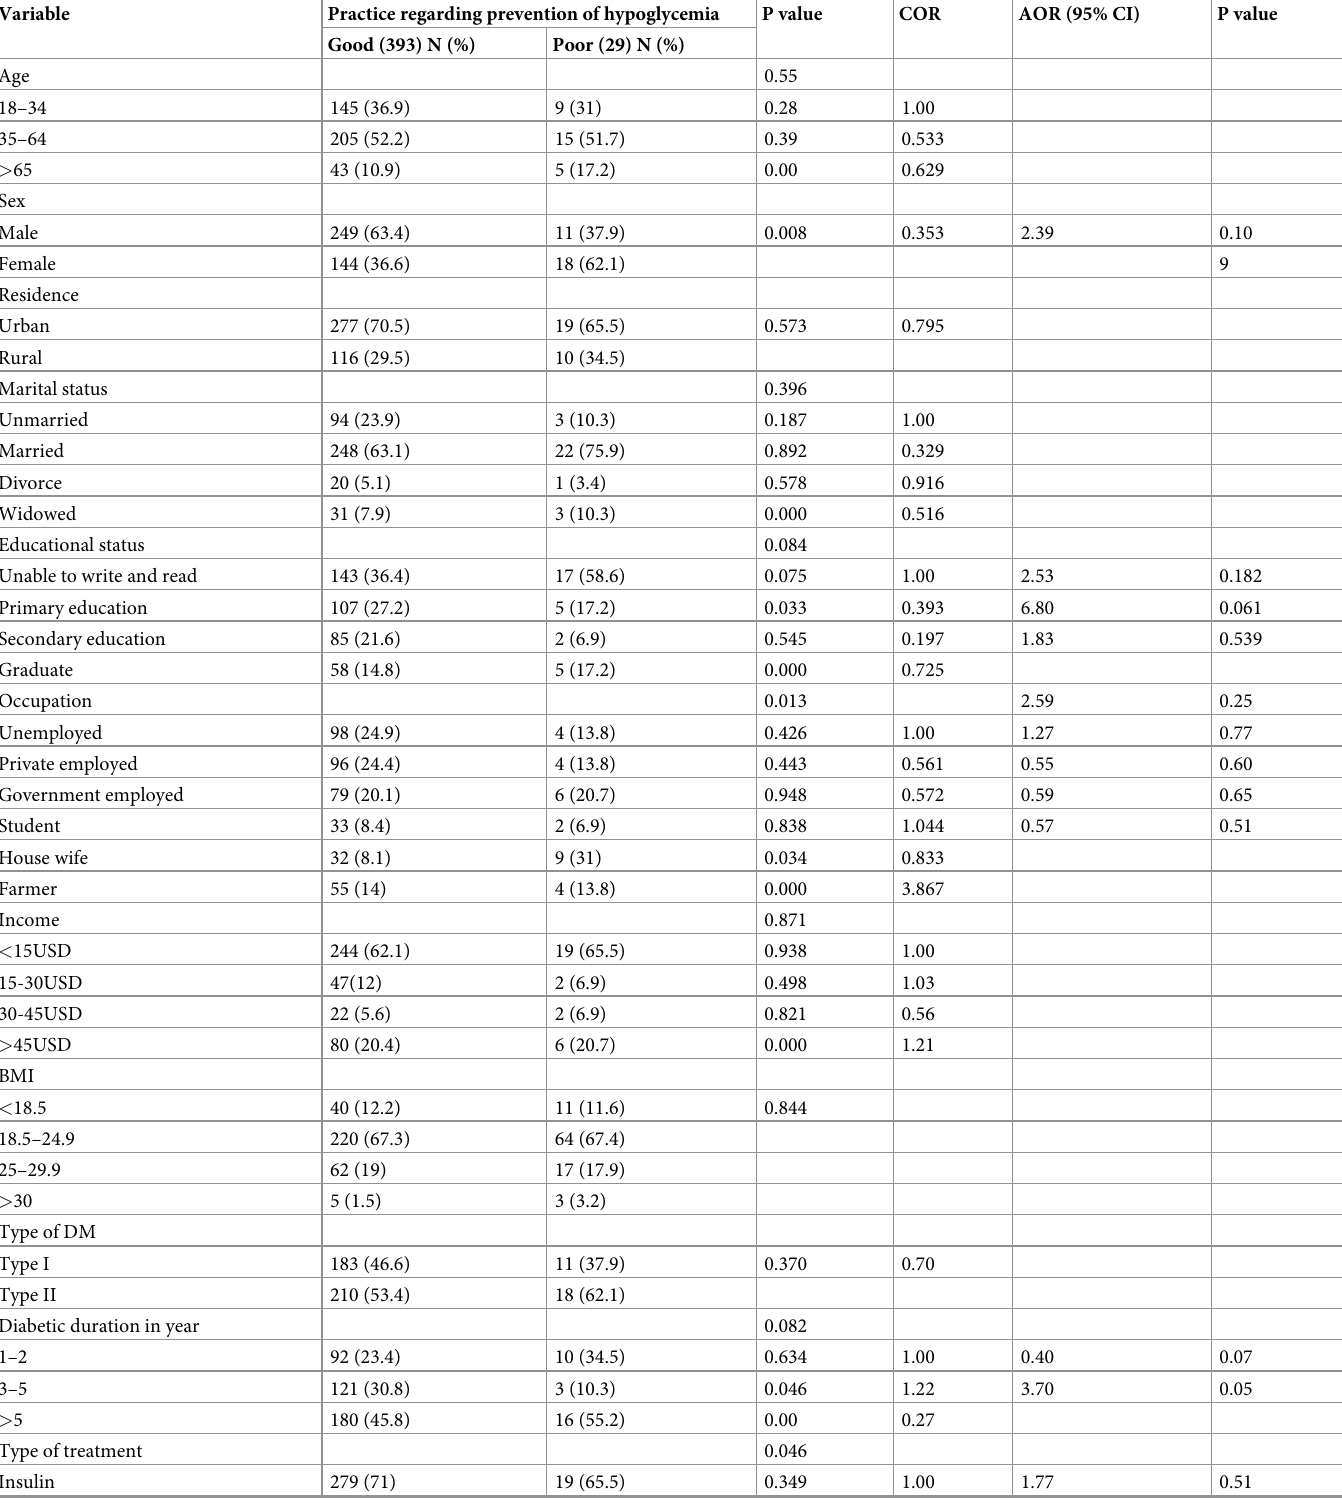
Table 5. Factors associated with hypoglycemia prevention practice among study subjects, UoGRTH, North-west- Ethiopia, 2019 (N = 422).